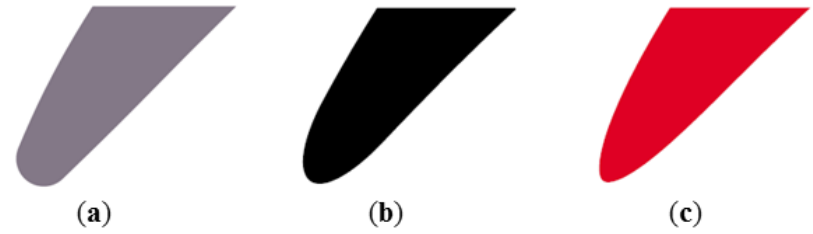
Figure 2. Spikeless continuous-curvature leading edge in [3]: ( a ) circular LE; ( b ) elliptical LE; ( c ) spikeless continuous-curvature